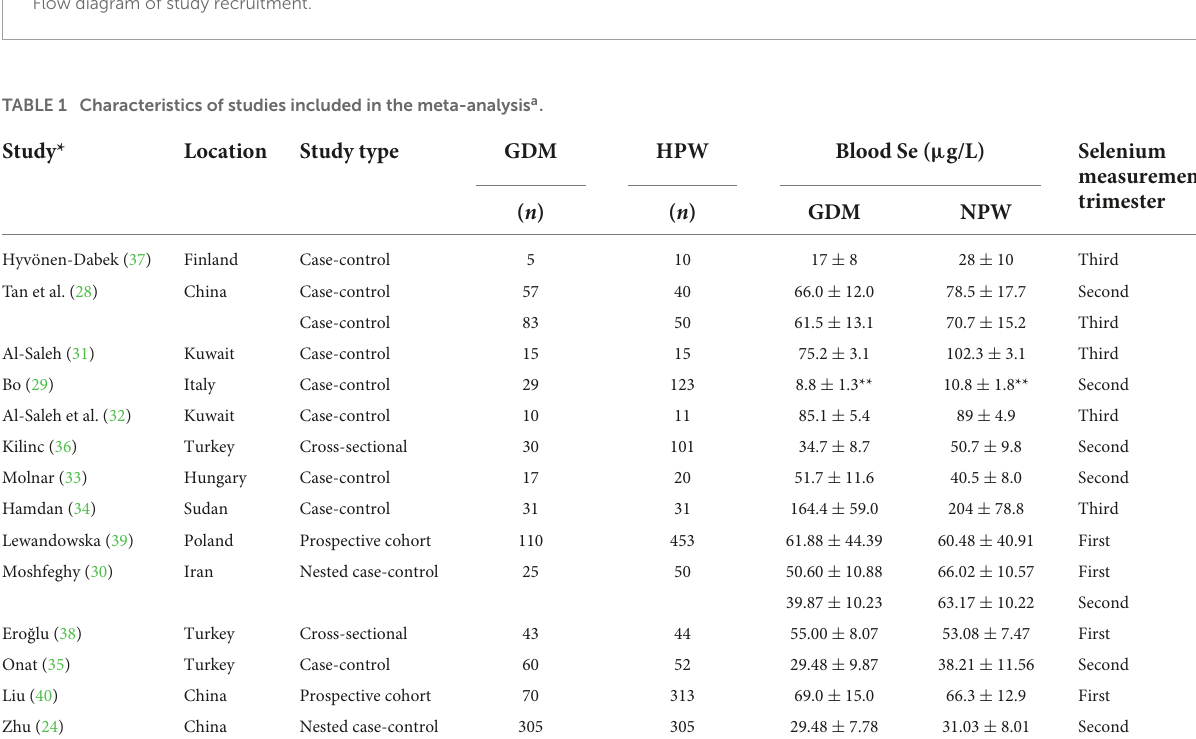
FIGURE1 Flow diagram of study recruitment.